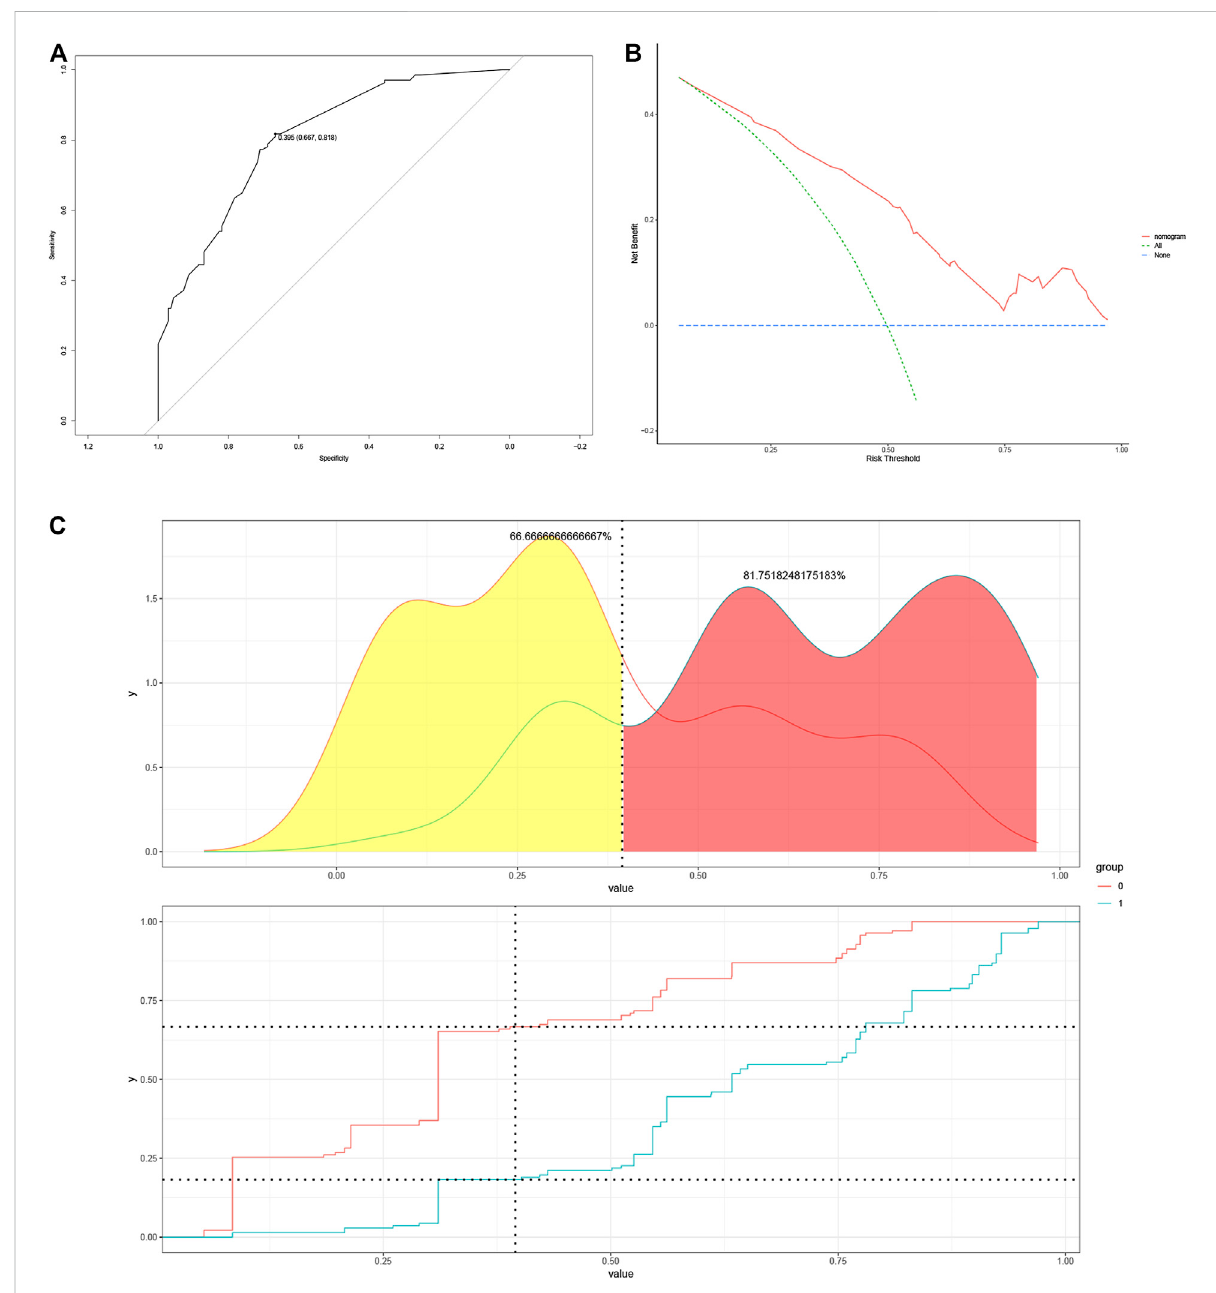
FIGURE 3 (A) Determination of optimal cut-off points based on ROC curves. (B) The risk density map and clinical utility map. The red curve represents BRAF gene without mutation, and the blue curve represents BRAF gene mutations. (C) DCA plots for the nomogram. ROC, Receiver Operating Characteristic; DCA, Decision Curve